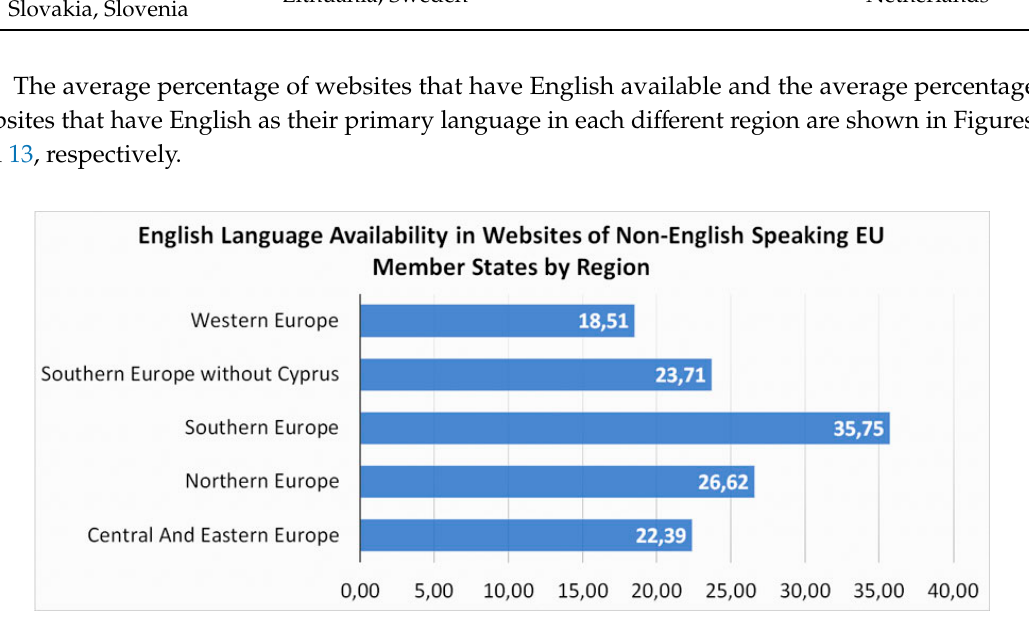
Table 8. Non-English speaking Countries divided to four European Regions as defined by EuroVoc. Central and Eastern